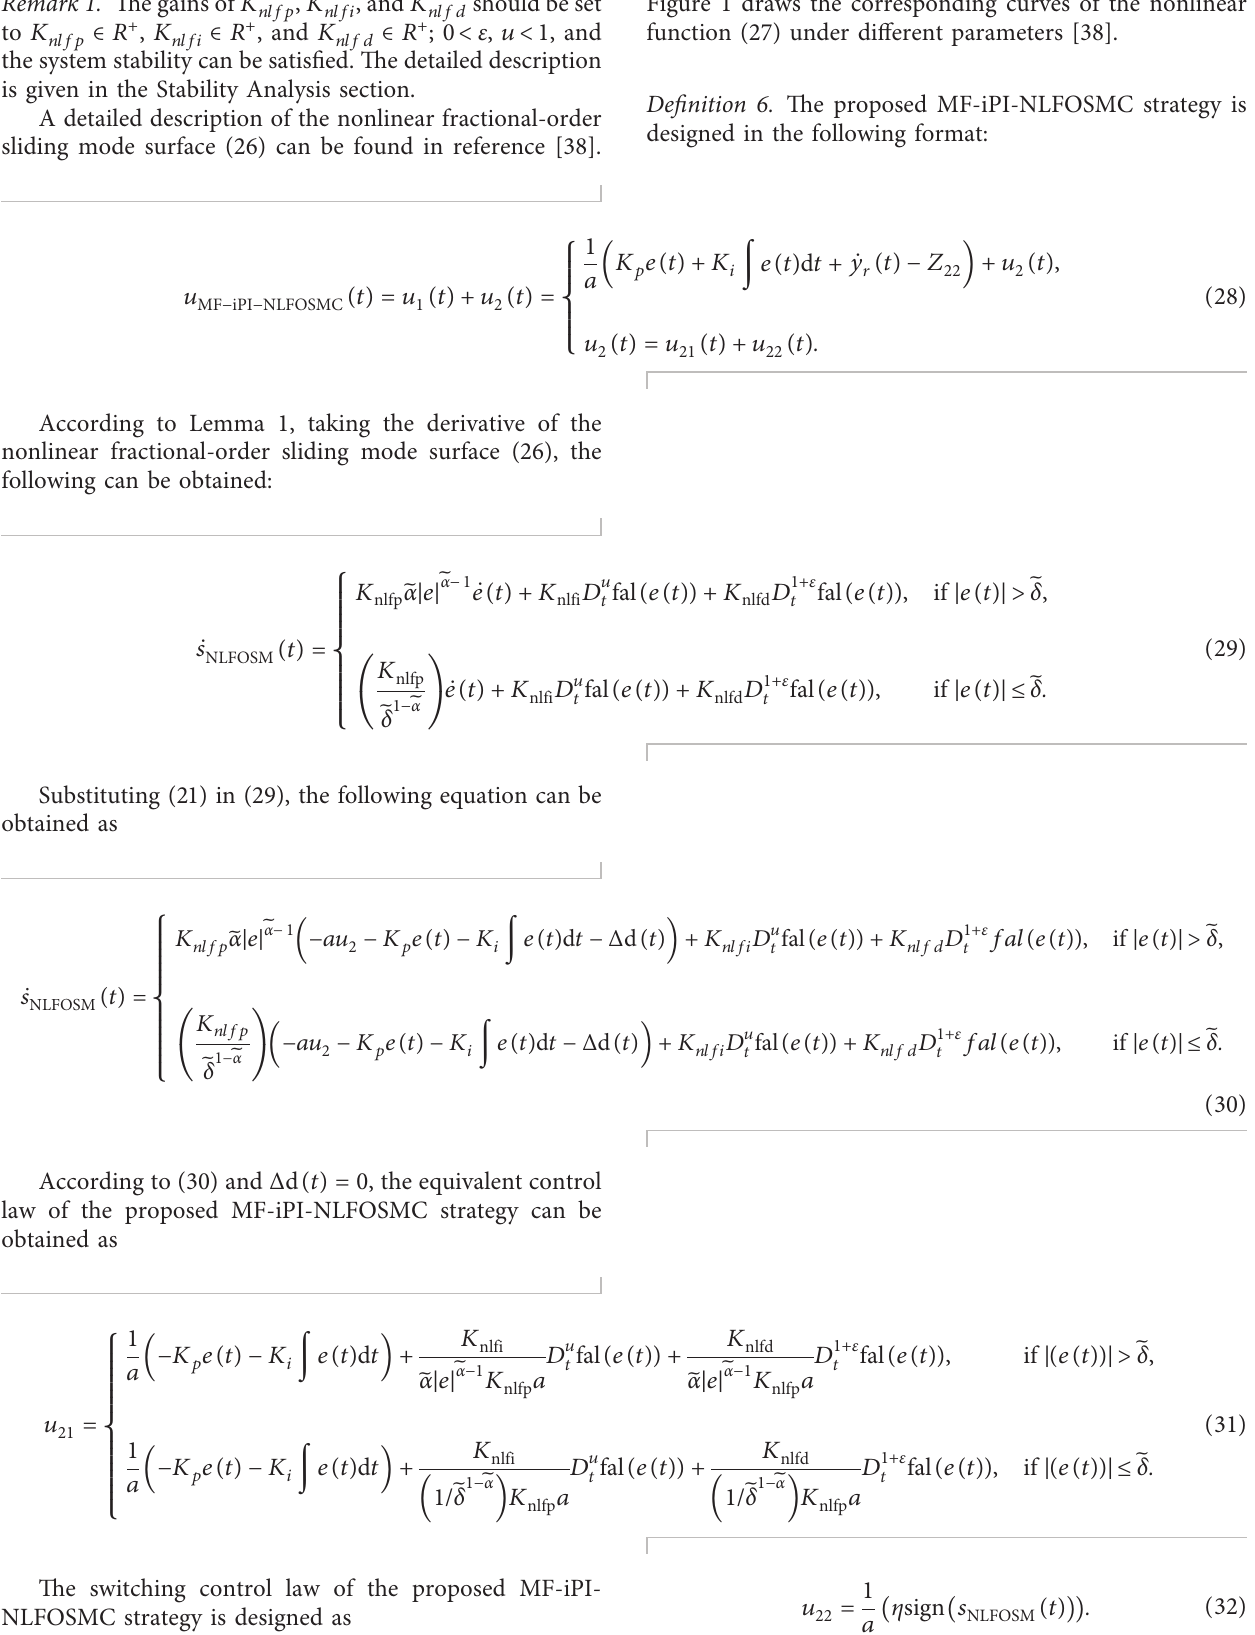
Figure 1 draws the corresponding curves of the nonlinear function (27) under different parameters